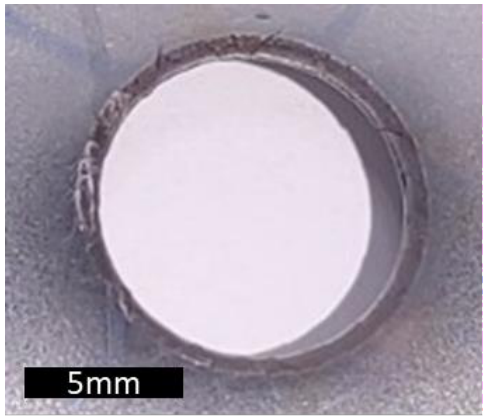
Figure 8. Sample after the hole expansion test (source: author) .